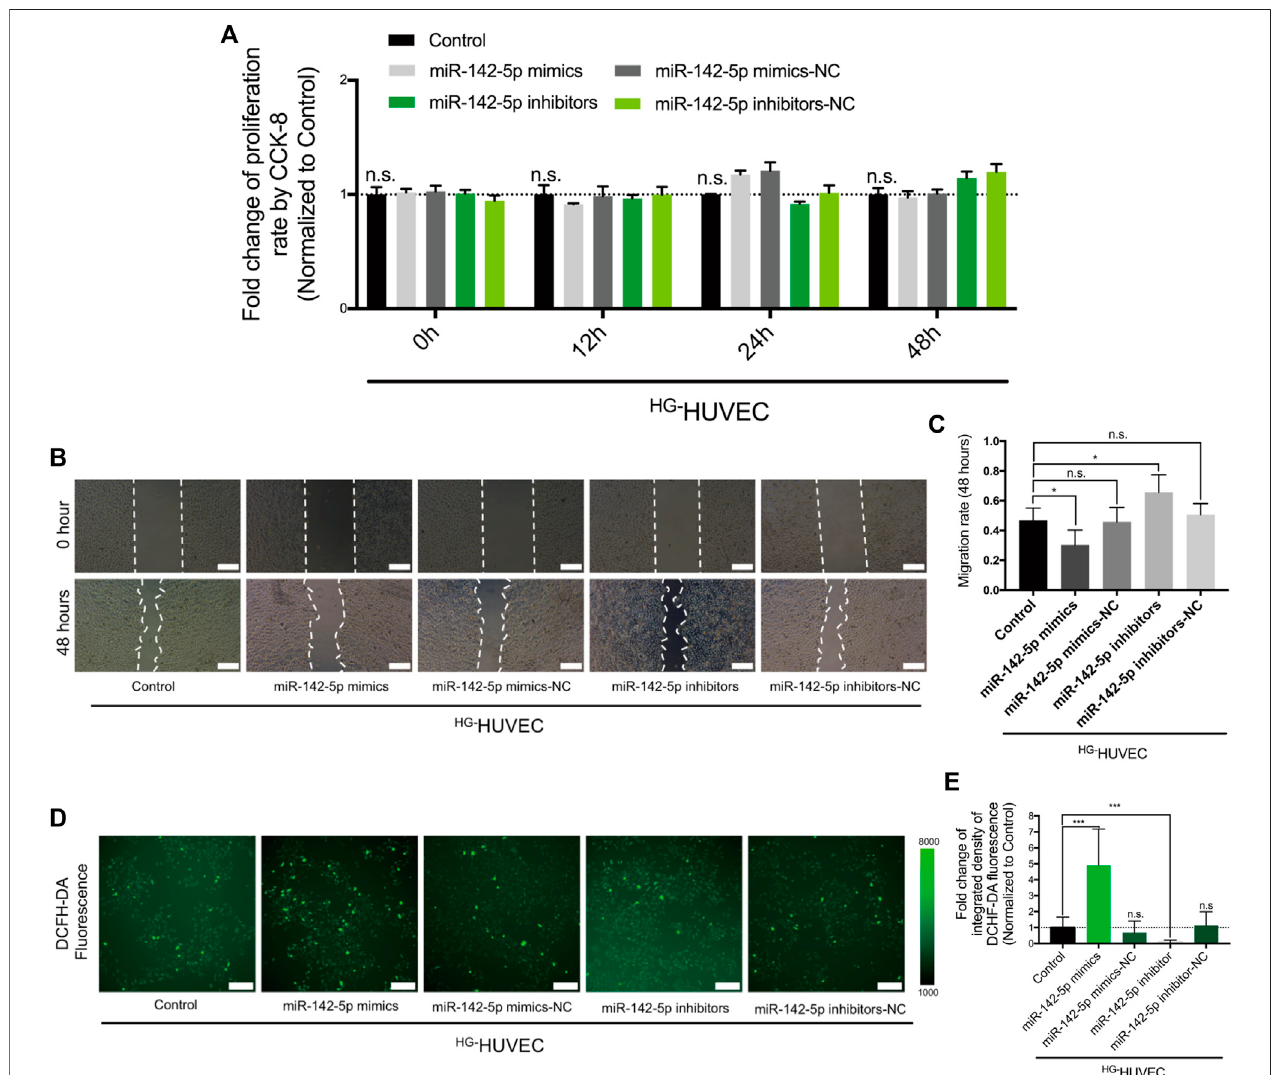
FIGURE 5 | The regulatory effects of miR-142-5p on HG- HUVECs (A) The impact of miR-142-5p on HUVECs proliferative ability (B) The impact of miR-142-5p on HUVECs migration. Scale bar = 200 μ m (C) Quantitative analysis of migration rate (D) The impact of miR-142-5p on the production of ROS in HUVECs detected by DCFH-DA fl uorescence.Scalebar =200 μ m (E) Quantitative analysisofDCFH-DA fl uorescence.Dataarepresented asmean±SDandanalyzedusingtheANOVA, n.s not signi fi cant, * p < 0.05, *** p < 0.001. n = 3.